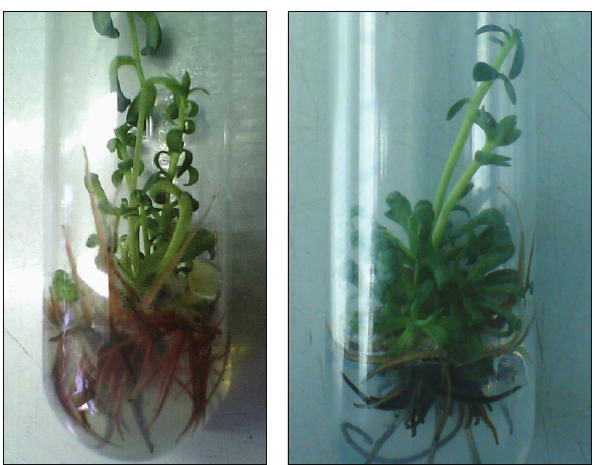
Figure 7: Induced rhizogenesis and propagation in Rh. rosea regenerated plants on MS medium enriched with 2.0 mg/L IBA, 0.2mg/L IAA, and 0.4 mg/L GA 3